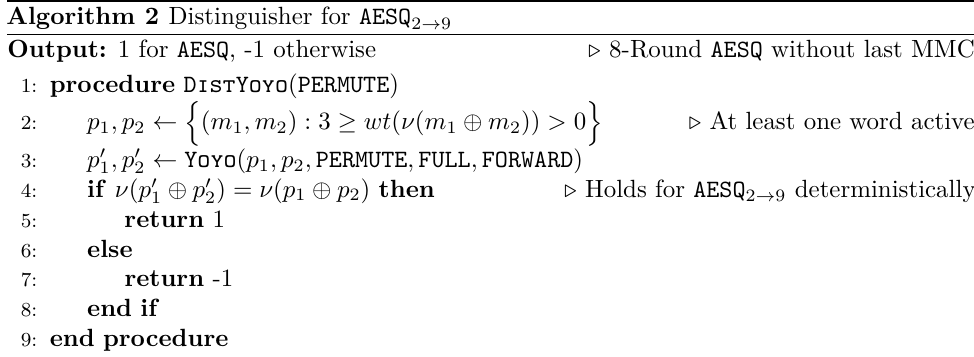
Algorithm 2 Distinguisher for AESQ